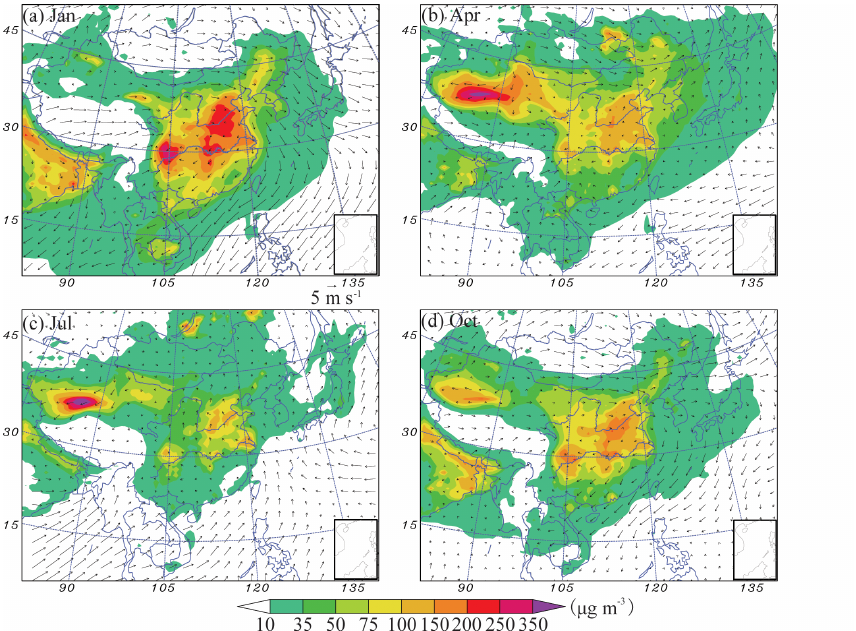
Figure 4. The horizontal distributions of the modeled monthly PM 2 . 5 mass concentration in January, April, July, and October in 2015. Also shown are the surface wind fields.